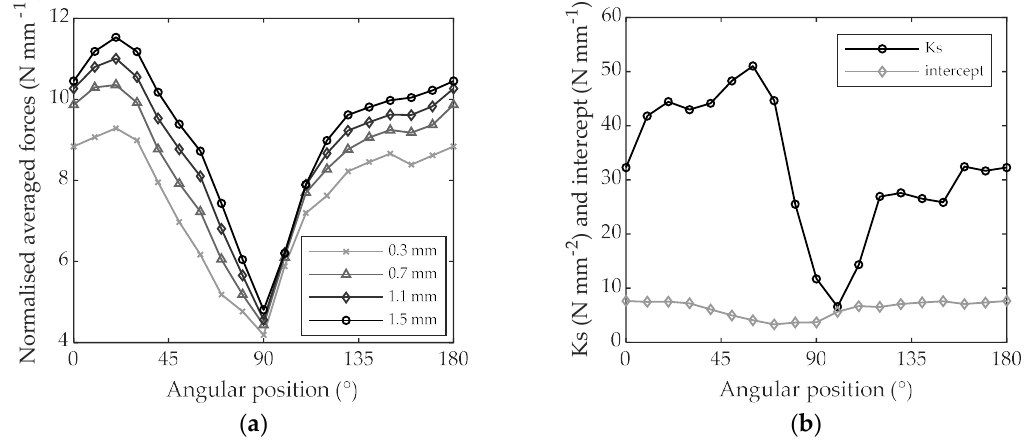
Figure 12. ( a ) Average cutting forces referring to the cutting period versus angular position when machining beech LVL with 0.3, 0.7, 1.1 and 1.5 mm of depth of cut; ( b ) intercept and specific cutting coefficient gathered every 10° of angular position.